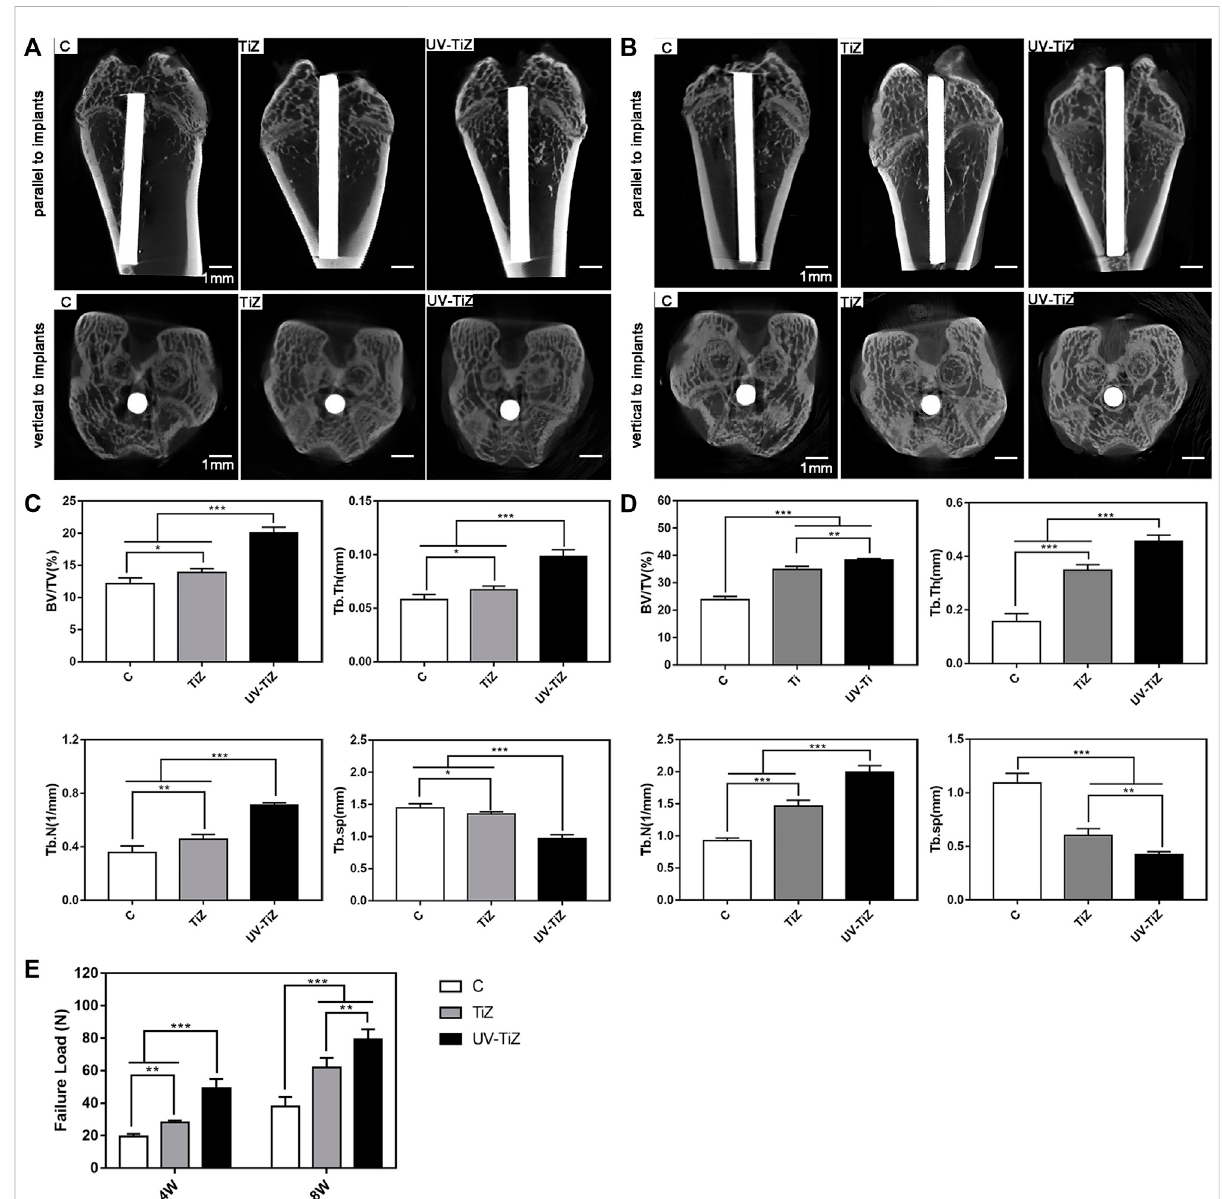
FIGURE 6 Representative 3D-reconstructed micro-CT images of the bone around each group of implants after 4 w (A) and 8 w (B) . Quantitative statistics ofBV/TV,Tb.Th,Tb.NandTb.Spaccordingtothemicro-CT imagesafter 4w (C) and8w (D) . (E)